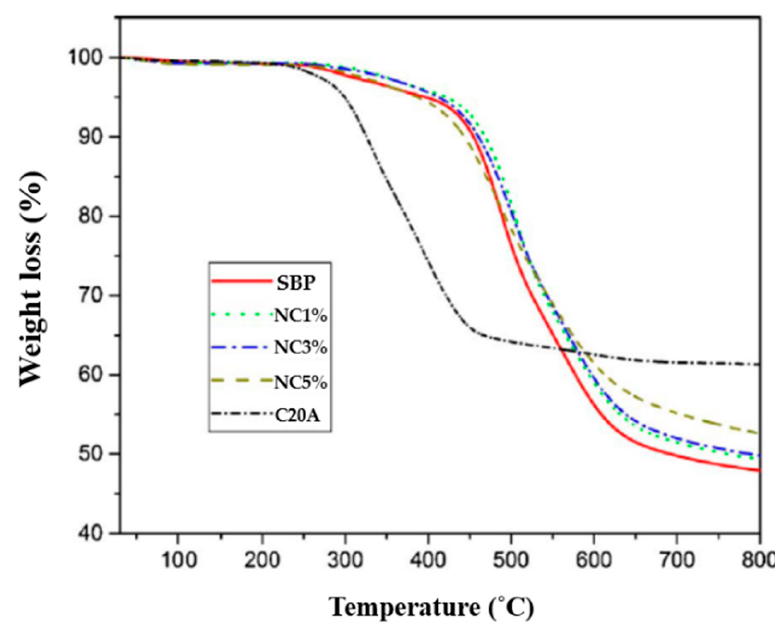
Figure 12. TGA of neat SBP, organoclay, and nanocomposites. Table 3. TGA data of neat SBP and different nanoclays [78]. Organoclay wt.%